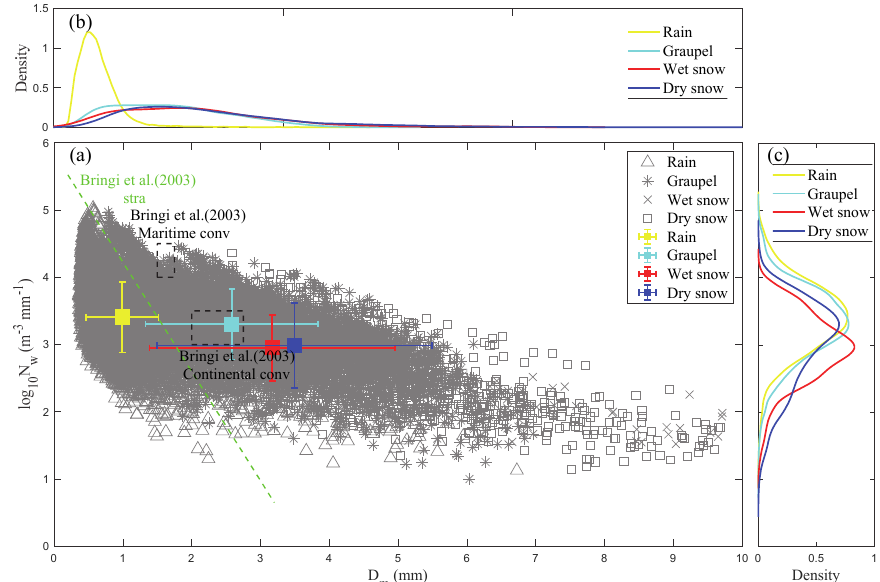
Figure 4. ( a ) The scatter distributions (gray triangle, asterisk, cross, square) and mean values (the length of the error bar is the standard deviation) of log 10 N w -D m of four types of precipitation. The dashed green line represents the fitting line for stratiform rainfall, and the dashed black rectangle represents the statistical area for continental and marine rainfall from Bringi et al. [28]; ( b ) The probability–density curves of D m of four types of precipitation; and ( c ) The probability–density curves of log 10 N w of four types of precipitation.